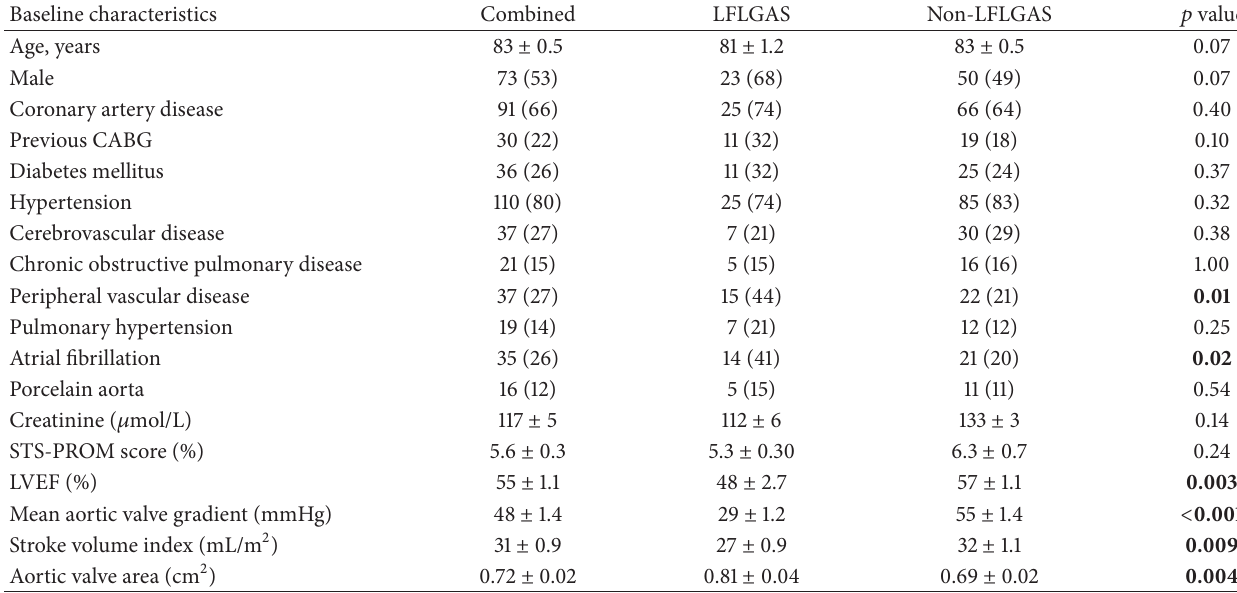
Table 1: Baseline characteristics.